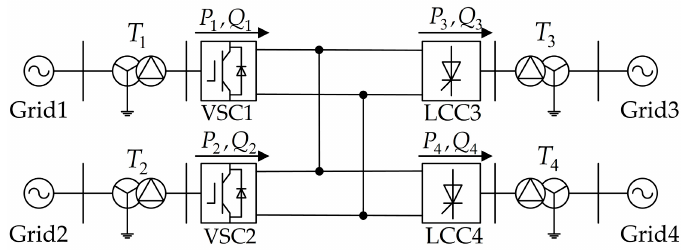
Figure 1. The topology of the parallel four-terminal hybrid HVDC system.